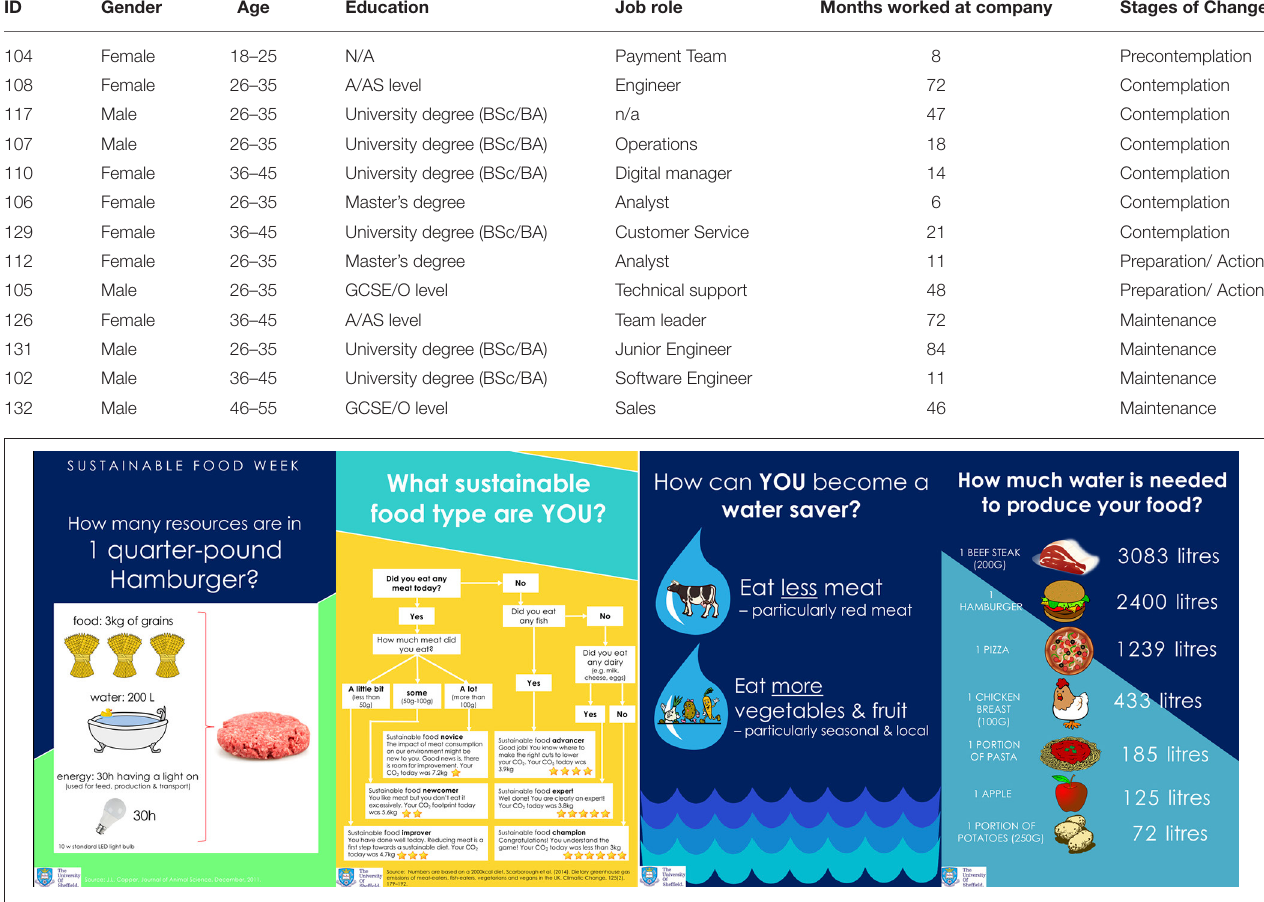
FIGURE 2 | Examples of information material used in behavior change